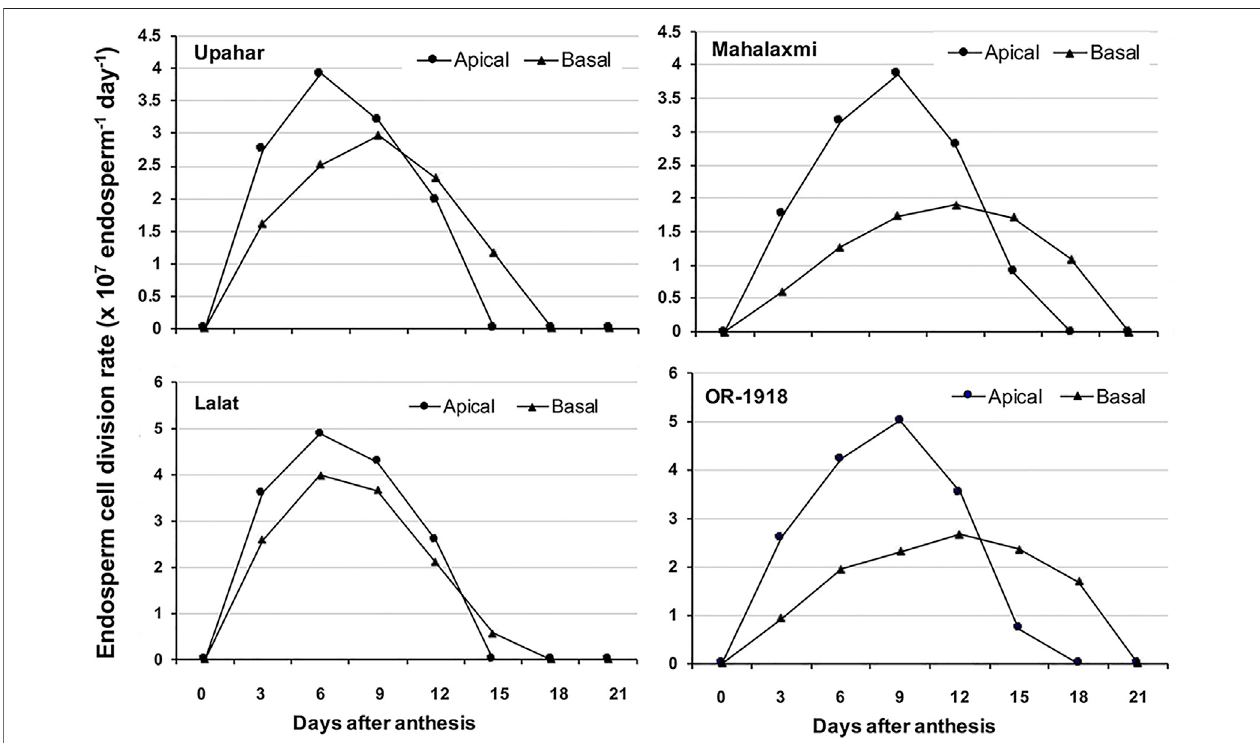
FIGURE 5 | Spatio-temporal depiction of the rate of endosperm cell division in two lax-panicle rice cultivars, Upahar and Lalat, and two compact-panicle rice cultivars,MahalaxmiandOR-1918.Thepeakoftheendospermcelldivisionrateintheapicalspikeletsreachesearlierinthelax-paniclecultivarscomparedwithcompact- panicle cultivars, and in the basal spikelets, the arrival of the peak is delayed greatly in the compact-panicle cultivars compared with the lax-panicle cultivars. The cessation of the endosperm cell division in the basal spikelets of the compact-panicle cultivars is also delayed greatly, almost 3 days, when compared with that of the lax-panicle cultivars, leading to poor grain fi lling in the former. Reproduced with the permission of the author (Sahu et al.,